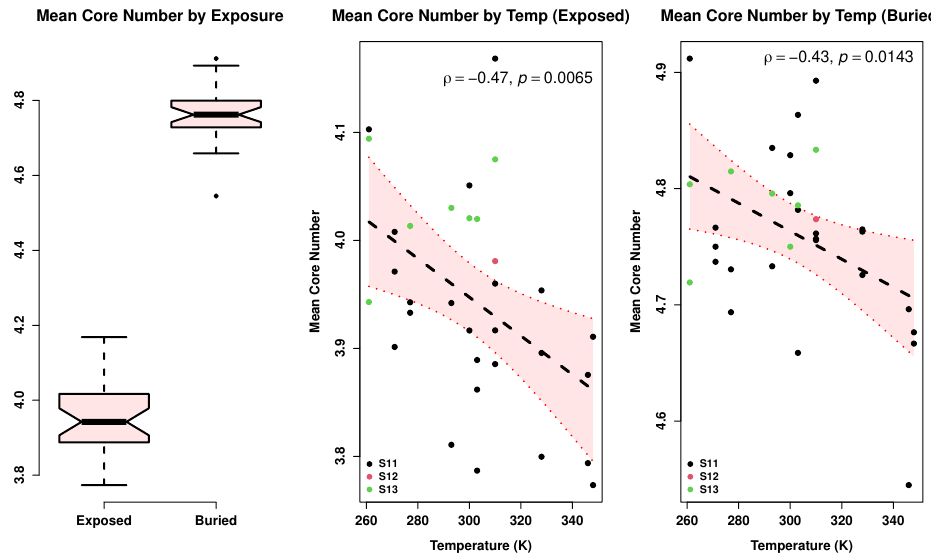
Figure 10. ( left ) Mean core number for moieties in exposed versus buried residues. ( right ) Rela- tionship between mean core numbers and observed environmental temperature, considering only exposed or buried residues, respectively (OLS fits shown by central lines; shaded area indicates the 95% confidence bands). While buried groups are generally in much more cohesive positions, environmental temperature has a similar association with cohesion for exposed and buried